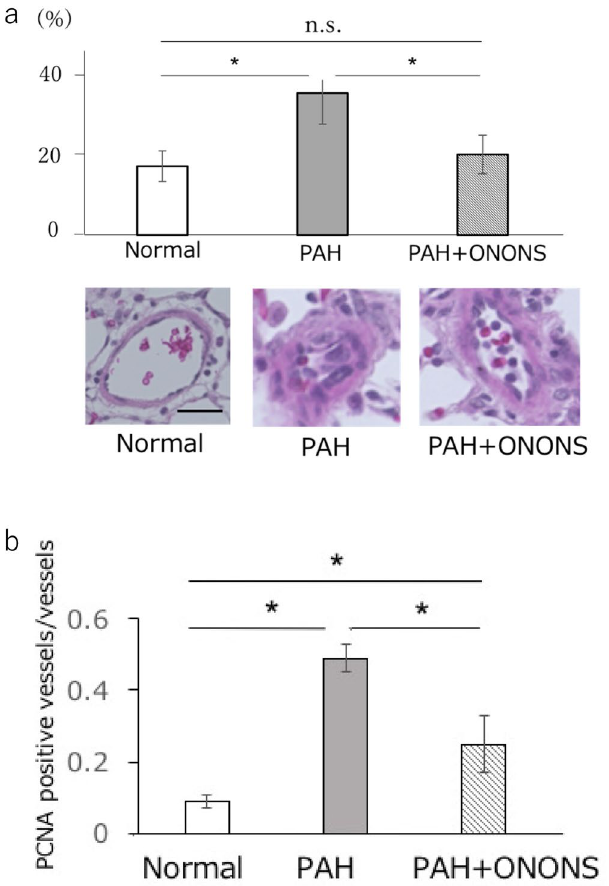
Figure 6. Histological analysis of proliferation of smooth muscle cells proliferation in PAH rats treated with ONO1301 nanospehre (ONONS). ( a ) The percent medial wall thickness in pulmonary small arteries was significantly decreased in the ONONS rats. ( b ) Proliferating cell nuclear antigen (PCNA) positive smooth muscle cells were significantly decreased in ONONS treated rats. n = 10. * P <